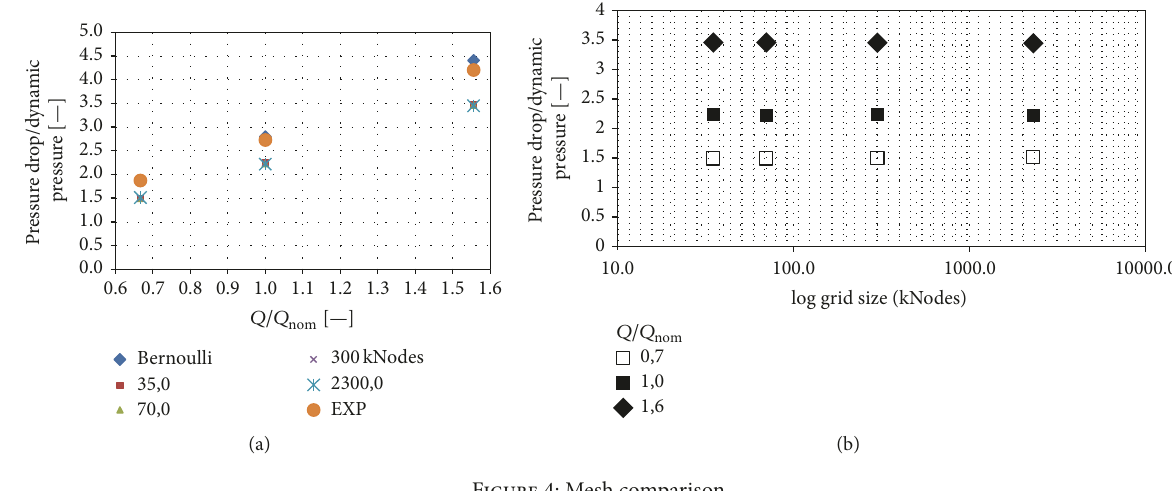
Figure 4: Mesh comparison.